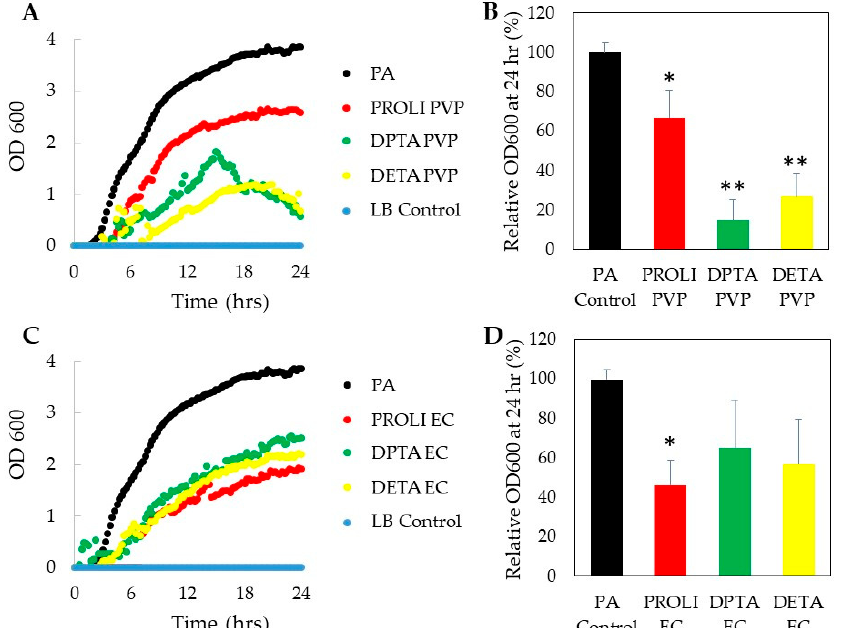
Figure 3. Antimicrobial effect of NO-fibers on P. aeruginosa , listed as PA. Growth curves of P. aeruginosa treated with PVP NO-fibers ( A ) and EC NO-fibers ( C ) over 24 h measured as optical density at 600 nm. The viability of P. aeruginosa at 24 h was compared to the untreated control following treatment with PVP NO-fibers ( B ) and EC NO-fibers ( D ). Data are shown as mean ± standard deviation (SD). n = 3 statistical significance: * p < 0.05, ** p < 0.01.